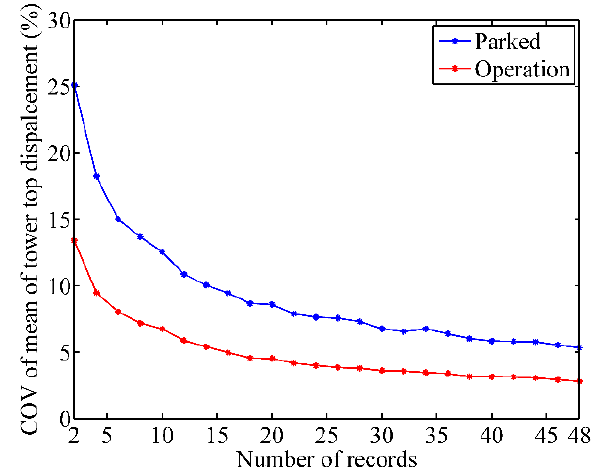
Figure 8. COV of the mean of maximum FA displacement with a different number of records.